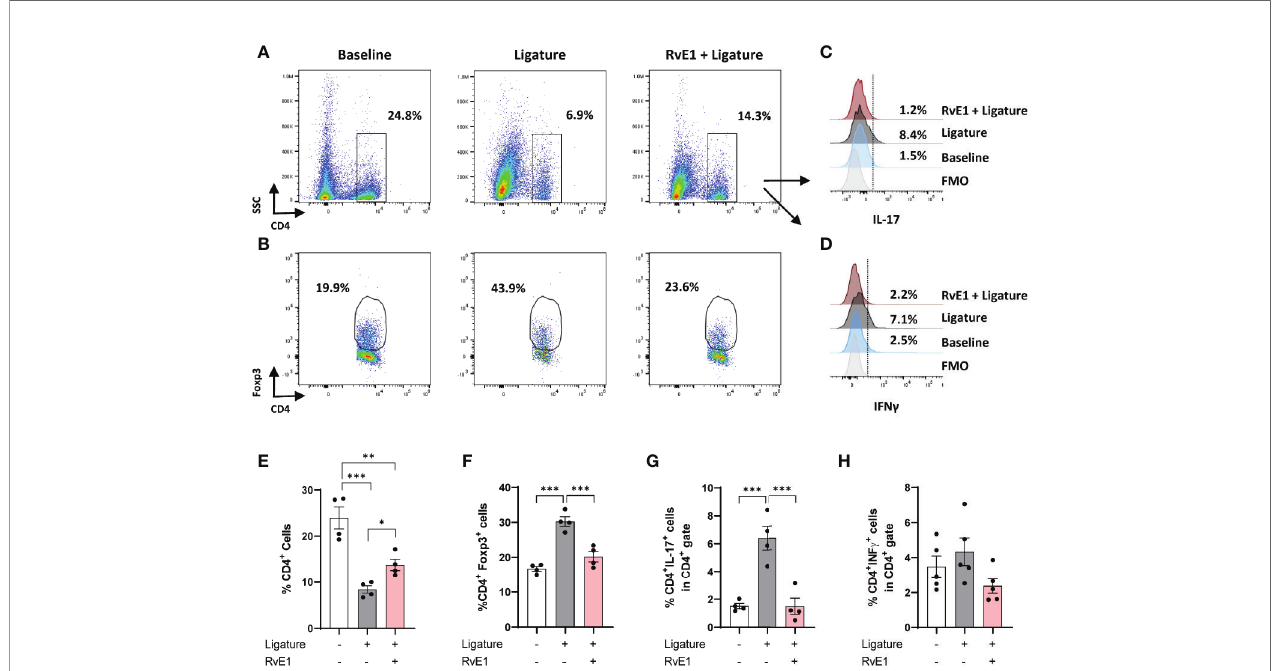
FIGURE 3 | Impact of early RvE1 administration on CD4 + cells in cervical lymph nodes. (A , B) Representative dot plots indicating the frequency of CD4 + and CD4 + Foxp3 + cells among all cells from cervical lymph nodes of animals with ligature-induced periodontitis (10 days; ligature), pre-treated with RvE1 (RvE1 + Ligature) or baseline (no ligature). (C , D) Representative histograms indicating the expression of IL-17 or IFN g in CD4 + cells. (E – H) Frequency of total CD4+ cells, CD4 + Foxp3 + cells, and CD4 + IL-17 or IFN g + cells in cervical lymph nodes (n = 4). FMO, Fluorescence minus one. *P < 0.05, **P < 0.01, ***P <